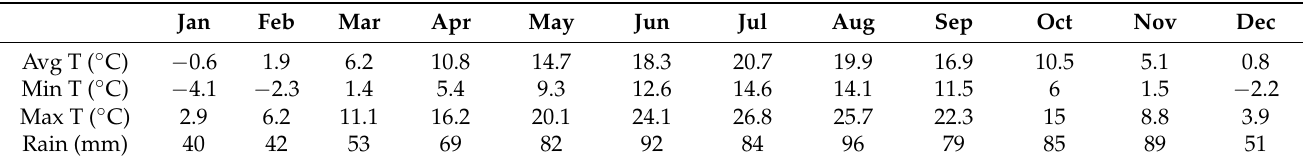
Table 1. Climate characterization [i.e., average, minimum, and maximum temperature ( ◦ C) and rain (mm)] of Tenna (average of the period 1982–2012). Source: Climate-Data. https://it.climate-data.org/europa/italia/trentino-alto-adige/